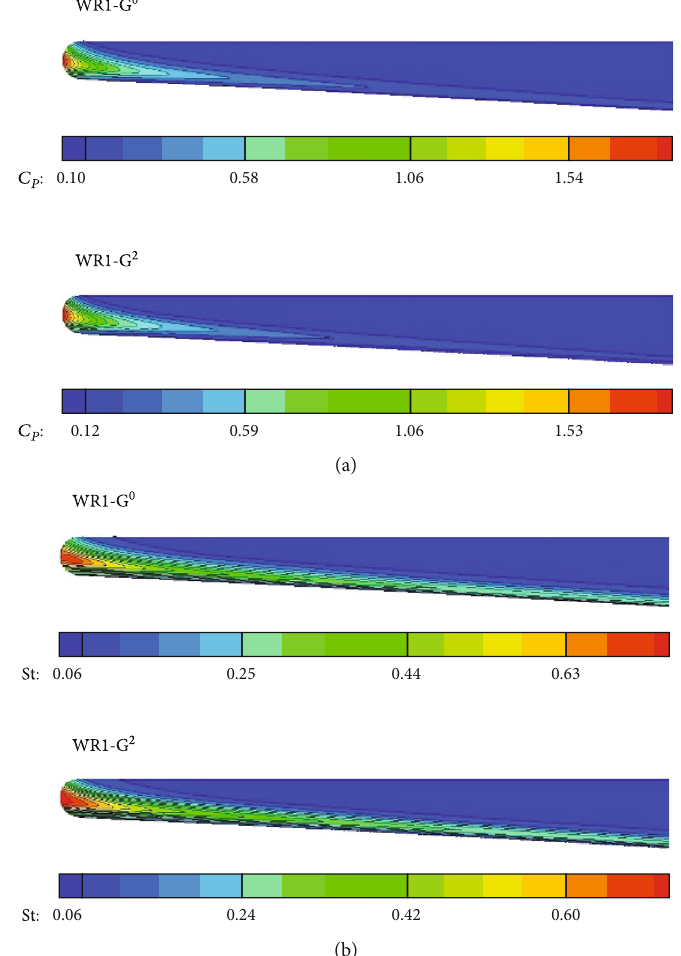
Figure 15: Contours of surface characteristics alongside leading edges of WR1-G 0 and WR1-G 2 : (a) contours of C